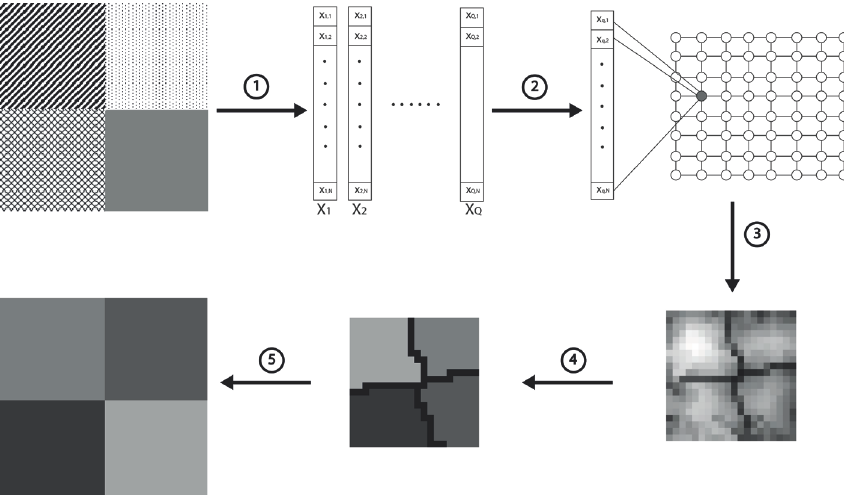
Fig. 4. Segmentation modules: (1) Features extraction, (2) Training the Kohonen map, (3) Representing the Kohonen map by the PDF, (4) Application of the watershed transfor- mation to extract the homogeneous regions, (5) Segmentation of the